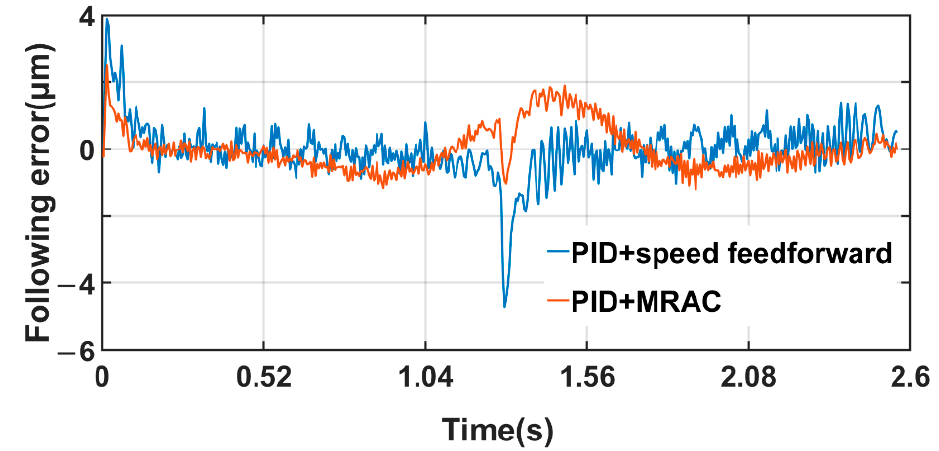
Figure 19. Comparison of following error of the two methods.